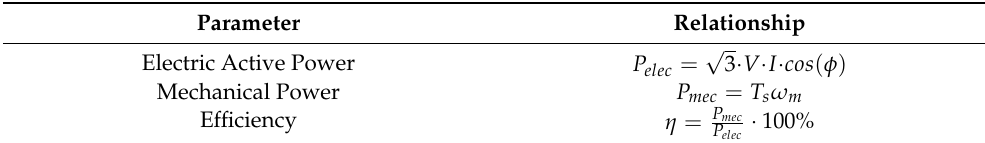
Table 1. Relationships to calculate electrical power, mechanical power, and efficiency for three- phase motors.